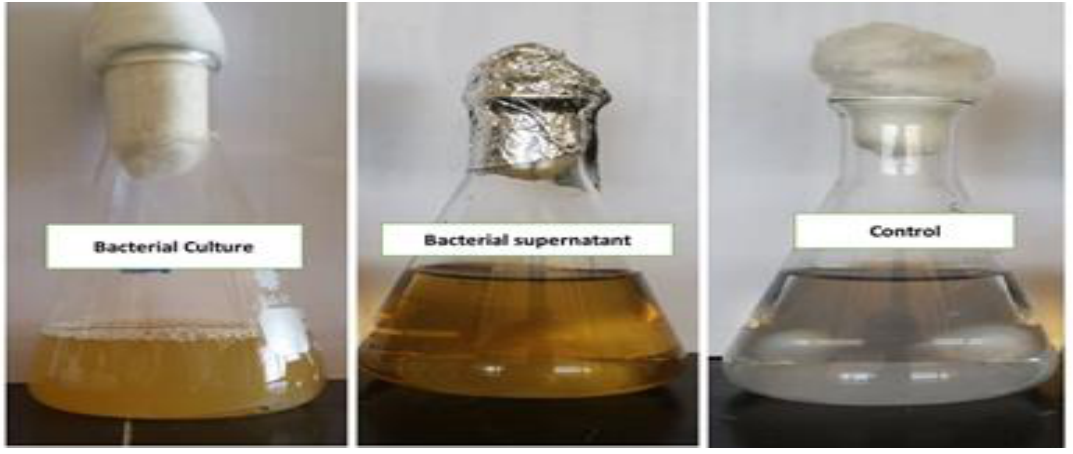
Figure 3. The bacterial supernatant with 25% of supernatant and 1mM of silver nitrate in scroller A, The bacterial supernatant with 50% of supernatant and 1mM of silver nitrate in scroller B, The bacterial supernatant with 50% of supernatant and 2 mM of silver nitrate in scroller C before and after incubation for 48 h.